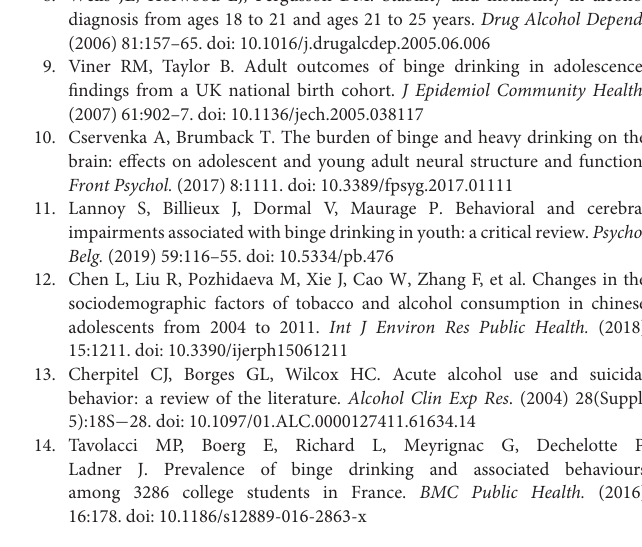
Supplementary Table 1 | The association between binge drinking, different types of bullying victimization, and socio-demographic characteristics as well as relevant health risk behaviors among ever drinkers ( N = 18,775, model 4). drinkers by adjustment for sociodemographic factors (full